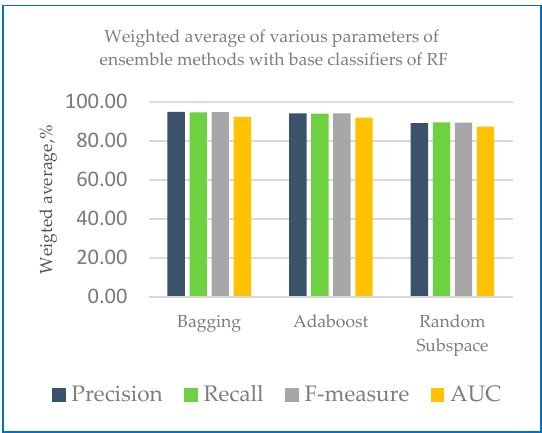
Figure 13. Weighted average of various parameters of ensemble methods with base classifiers of RF.